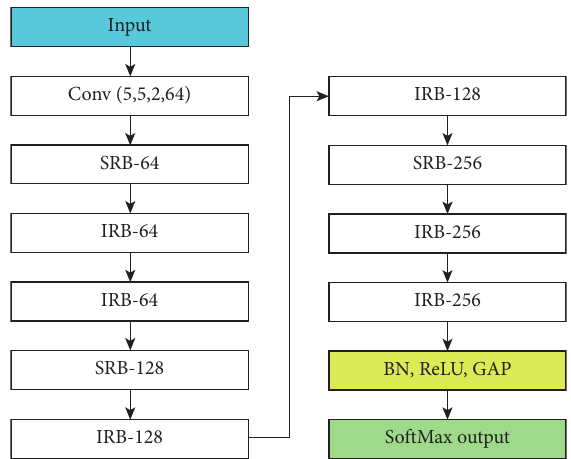
Figure 2: Architecture of the deep residual